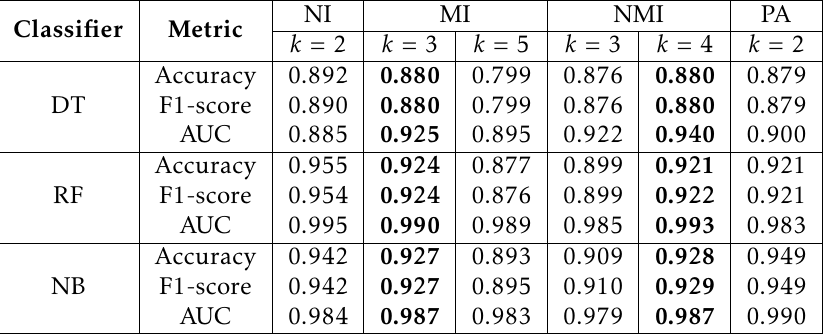
Table 4. Performance indicators of all classifiers we built for predicting and further validating the user clustering results of k -means. For MI and NMI datasets, we highlight the higher accuracy in bold face for the two possible values of k .